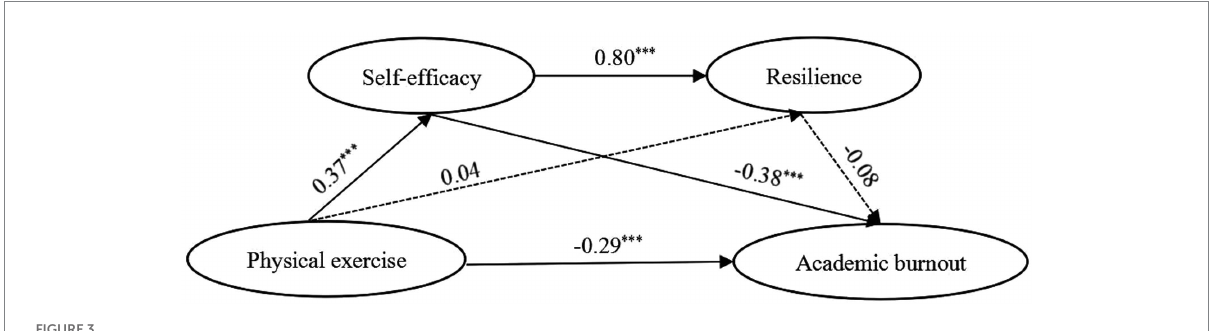
FIGURE 3 Model showing the mediating roles of self-efficacy and resilience in the relationship between physical exercise and academic burnout (Male sample). *** p < 0.001; significant standardized regression coefficient.